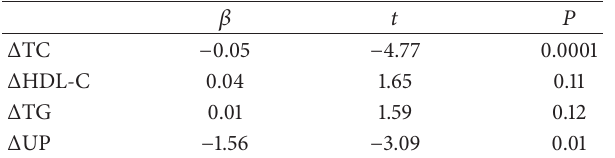
Table 4: Multivariate regression to the change in flow-mediated